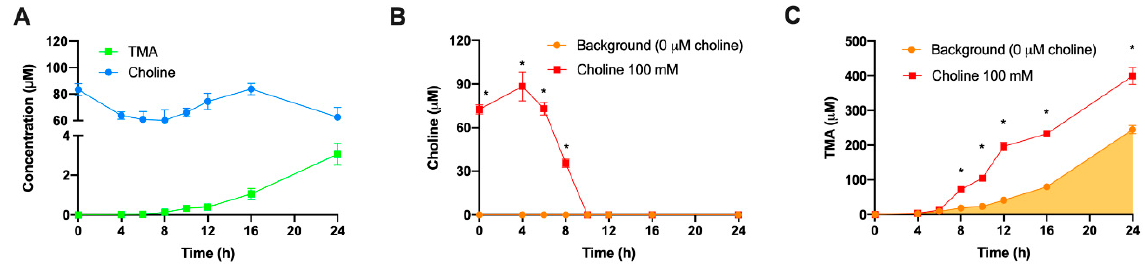
Figure 3. Choline and TMA changes in fecal slurry-free fermentation conditions ( A ). Changes in choline ( B ) and TMA ( C ) concentrations in fermentations with fecal slurry 20% and ± 100 µ M choline. In ( B ), time-matched choline concentrations in the background (from the mean detected choline levels in the 0 µ M choline treatment) are subtracted from choline- supplemented conditions in order to reflect only exogenous choline levels. Results are expressed as mean ( µ M choline or TMA) ± SEM ( n = 6). * indicates statistical differences ( p < 0.05) by time-matched two-way ANOVA (Tukey’s post hoc test). Orange shading indicates background TMA production.